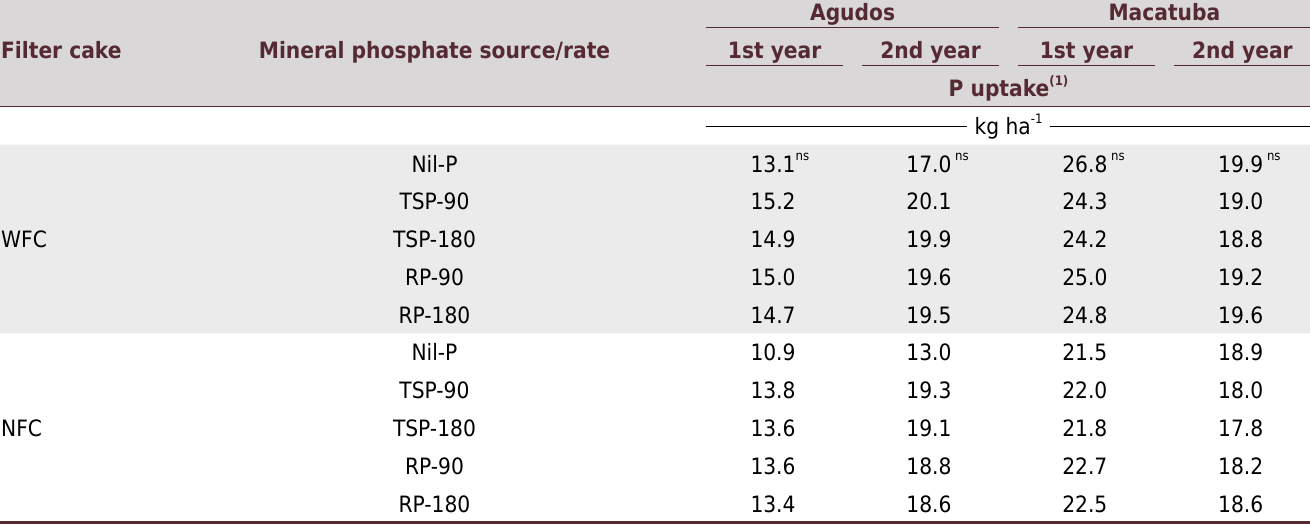
Table 3. Phosphorus uptake by sugarcane in two consecutive crop seasons as affected by filter cake addition and P sources and rates at crop establishment